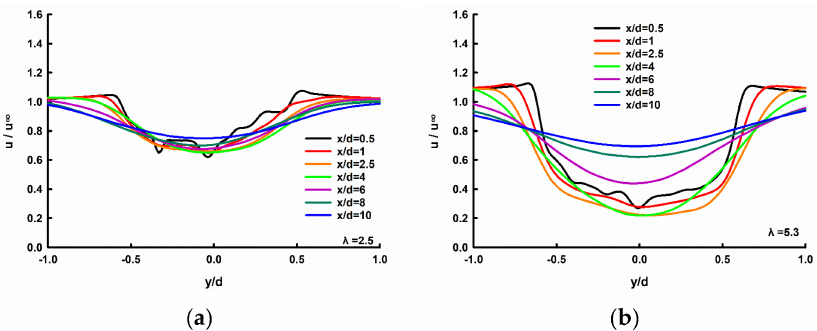
Figure 16. Time averaged normalised stream-wise wake velocity along − 0.75 d ≤ y/d ≤ +0.75 d for all wake distances for ( a ) λ = 2.5; ( b ) λ =